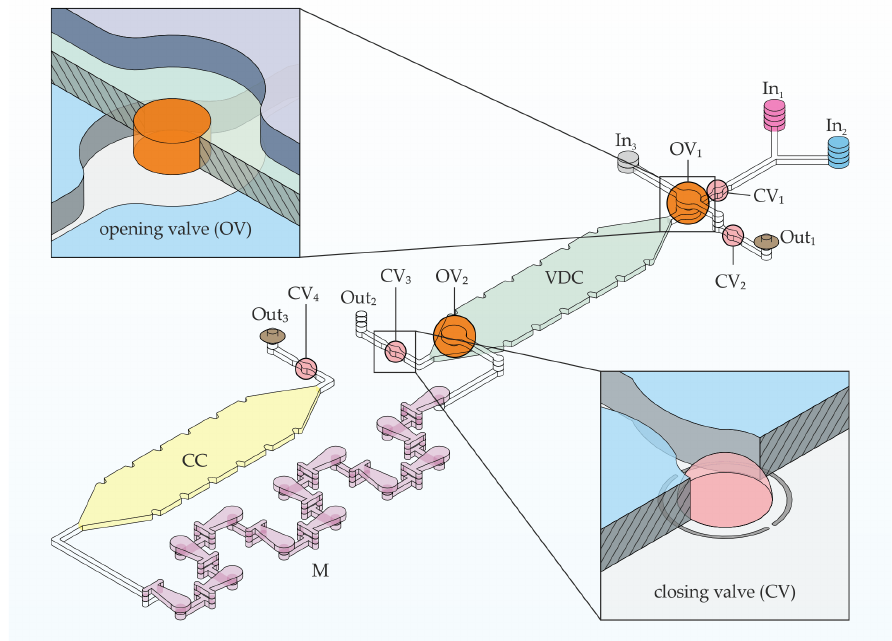
Figure 5. An isometric projection demonstrating the building elements and their arrangement in the application chip for volume definition, incubation and mixing of two liquids. The chip was constructed of six polymeric layers. Two insets showing isometric cross-section cutaways of closing outlet, VDC—volume definition chamber, CC—collecting chamber. The brown discs at Out 1 and Out 3 represent the integrated PTFE